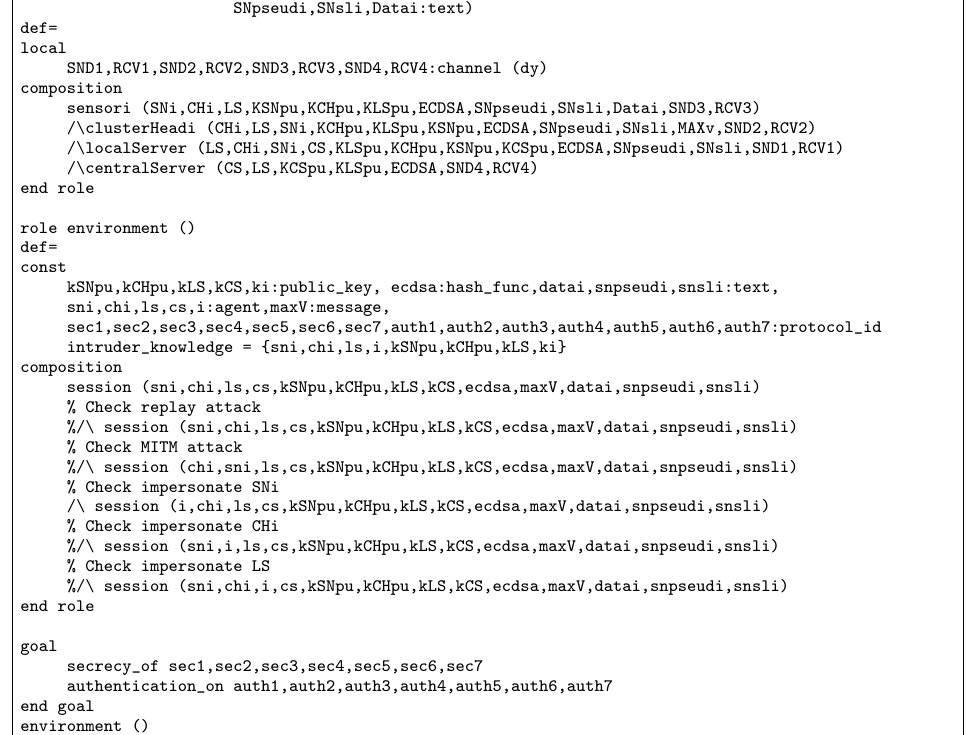
Figure 14. Supporting roles in HLPSL.